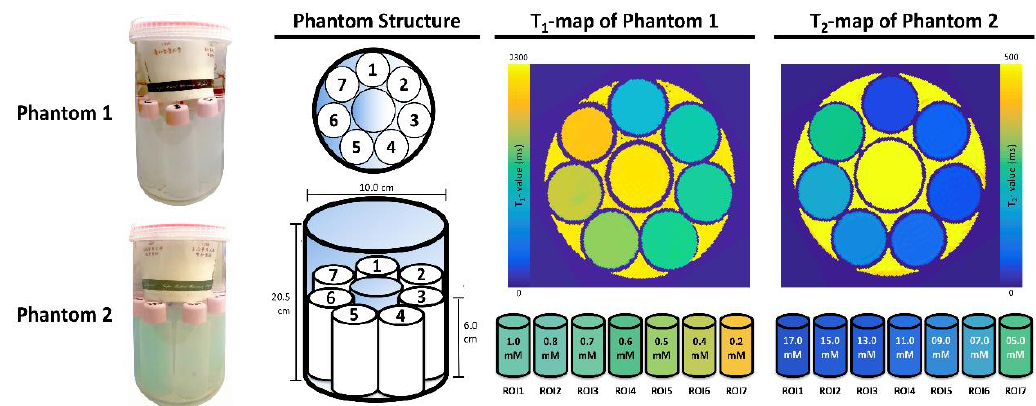
Figure 1. The structures of two phantoms designed for validating T 1 - and T 2 -value quantitation. Plastic tubes (cylinder structure with 7.1 cm 2 in dimension and 6.0 cm in height) filled with various concentrations of CuSO 4 were sealed and fixed in the plastic tanks. The plastic tank was filled with normal saline to minimize image artifacts.